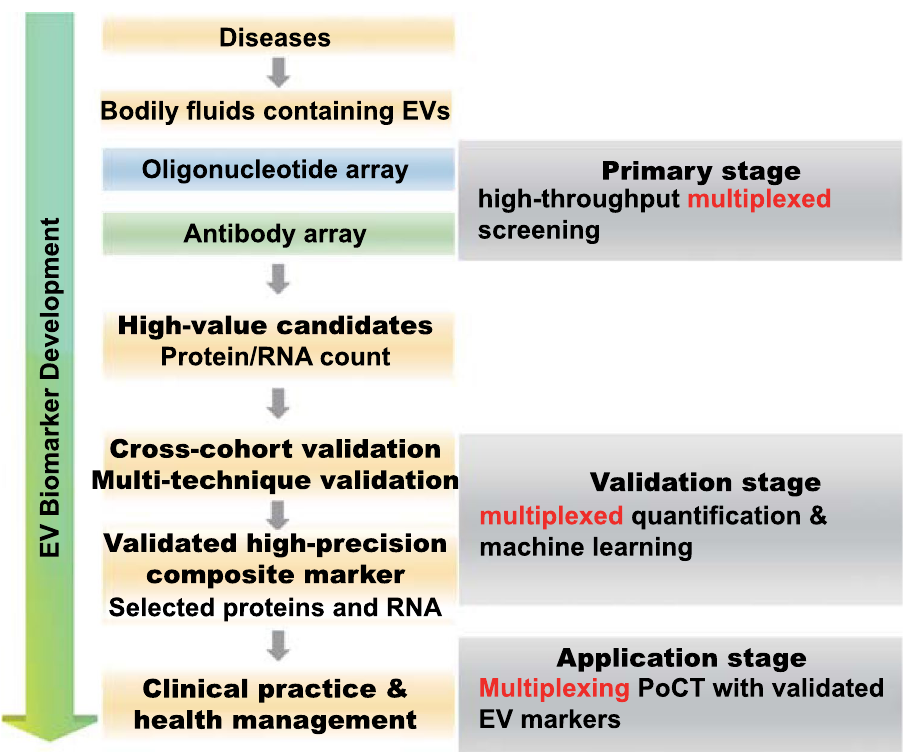
Fig. 11 Flowchart of EV biomarker development powered by multiplexing